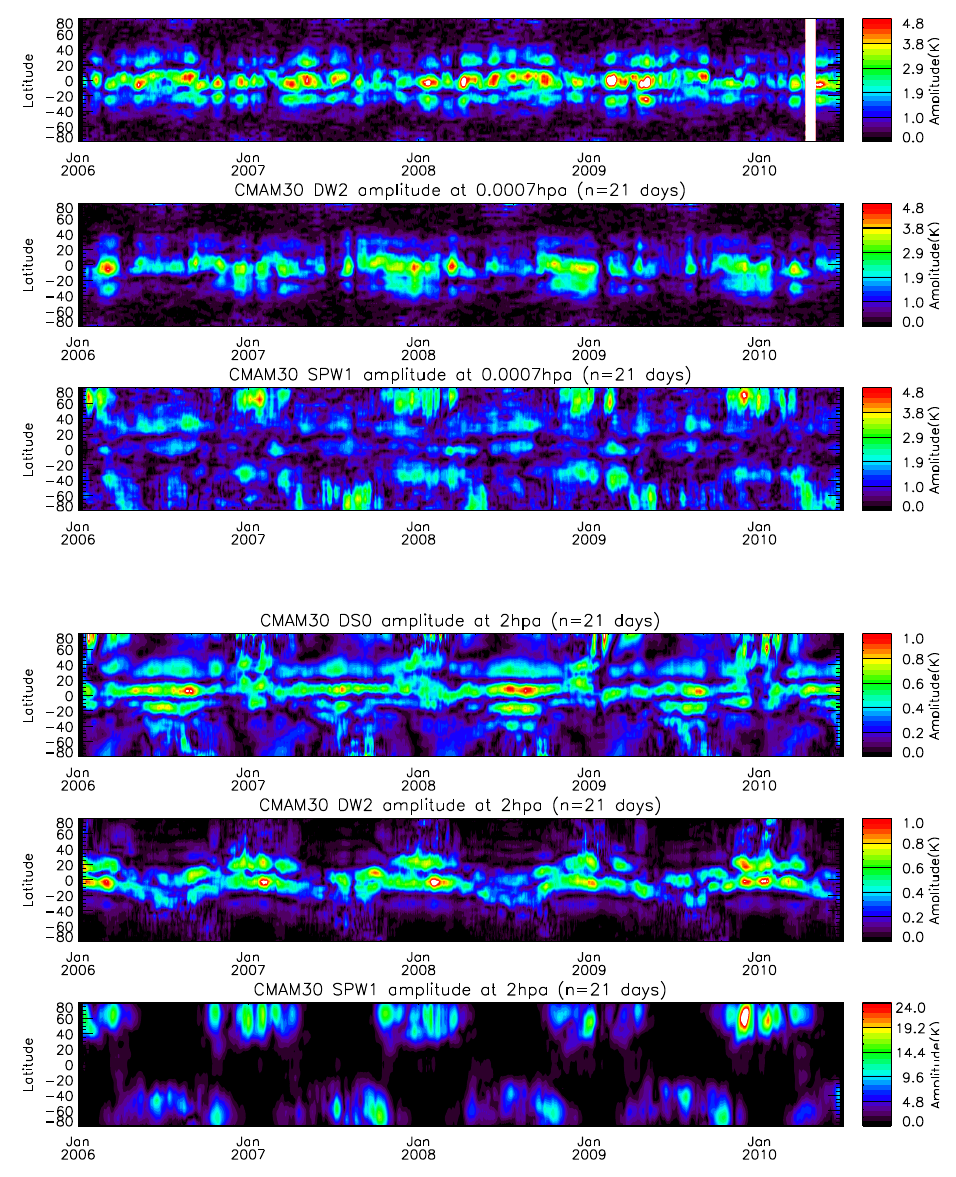
Figure 8. Latitude versus time variation of amplitudes of DS0, DW2, and SPW1 tide at 0.0007 hPa ( ∼ 95 km, in the top three panels) and 2 hPa ( ∼ 40 km, in the bottom three panels) from CMAM30 temperature